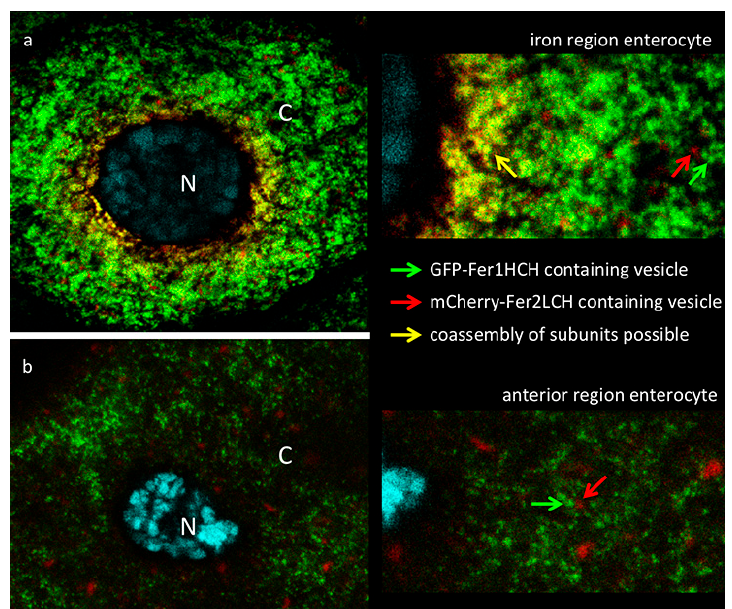
Figure 3. ( a ) Confocal image of iron region enterocyte (N—nucleus, DNA marked with DAPI in cyan, C—cytoplasm). Green fluorescence is from GFP-Fer1HCH; red fluorescence from mCherry-Fer2LCH; yellow color indicates overlap of signals. Larvae of the genotype Fer1HCH G188 /Fer2LCH NP4763 , UAS-mCherry-Fer2LCH were grown on a diet supplemented with 1 mM FAC. A close-up view on the right is provided for the viewer to note (i) that in a limited number of perinuclear Golgi vesicles (yellow arrow) GFP-Fer1HCH co-localizes with mCherry-Fer2LCH; and (ii) further in the periphery the vesicles containing GFP-Fer1HCH (green arrow) are clearly distinguishable from those containing mCherry-Fer2LCH (red arrow); ( b ) Single enterocyte of the anterior midgut region of the same larva—no co-localization observed between GFP-Fer1HCH and mCherry-Fer2LCH.